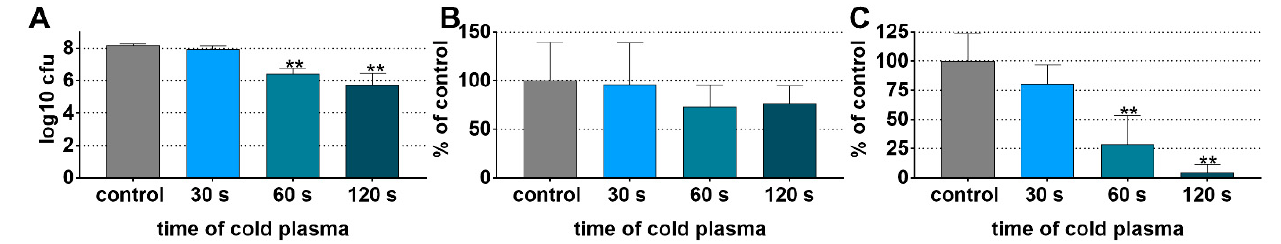
Figure 2. Colony forming units (CFU) counts ( A ), mass ( B ), and metabolic activity ( C ) of multi- species biofilms on dentin specimens and subsequent exposing of 30 s, 60 s, and 120 s to cold plasma . ** p < 0.01 vs. control (post-hoc Bonferroni).